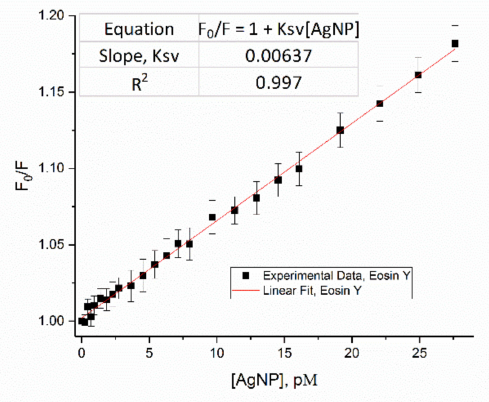
Figure 3. Fit of F 0 / F verse (AgNP) plot of eosin